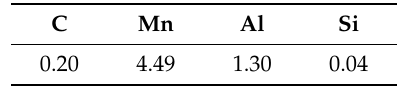
Table 1. Chemical composition of the investigated steel Fe-C-Mn-Al in wt.%.